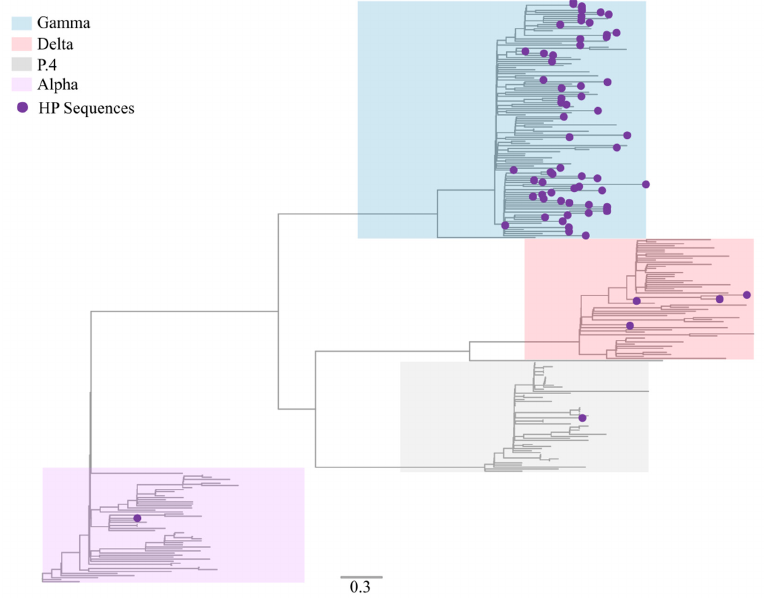
Figure 3. Maximum likelihood inference tree to confirm lineage classification using a reference dataset. The genomes generated in our study ( n = 69) are highlighted with purple circles. Lineages Alpha (B.1.1.7), Gamma (P.1), Delta (B.1.617.2), and P.4 are highlighted in violet, blue, red, and gray, respectively.